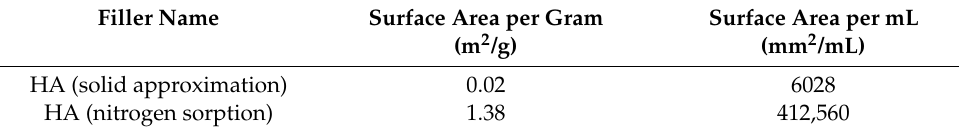
Table 3. Comparison of estimated and real surface area for HA